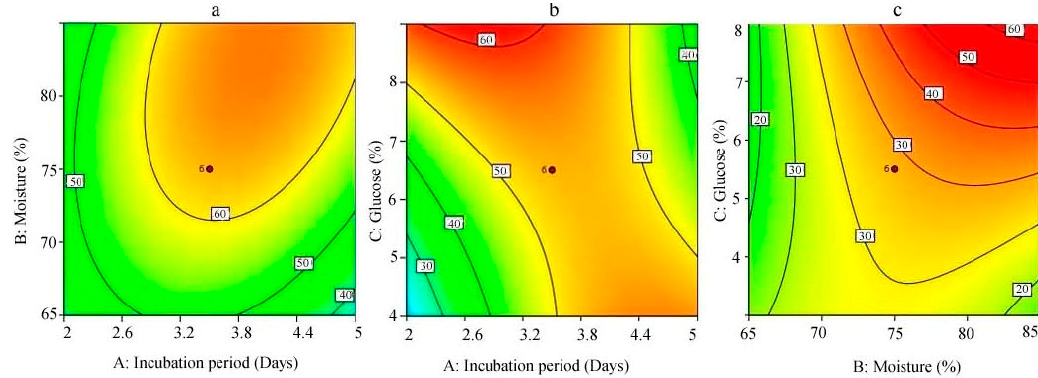
Figure 4. Contour plot for the surface tension property of biosurfactant produced by B. subtilis strain Al-Dhabi-130 at various process conditions. ( a ) Interactive effect of incubation period and moisture content, ( b ) interactive effect of incubation period and glucose, and ( c ) interactive effect of moisture and glucose. Table 3. Central composite design for the selected three variables for the production of biosurfactants in solid-state fermentation.